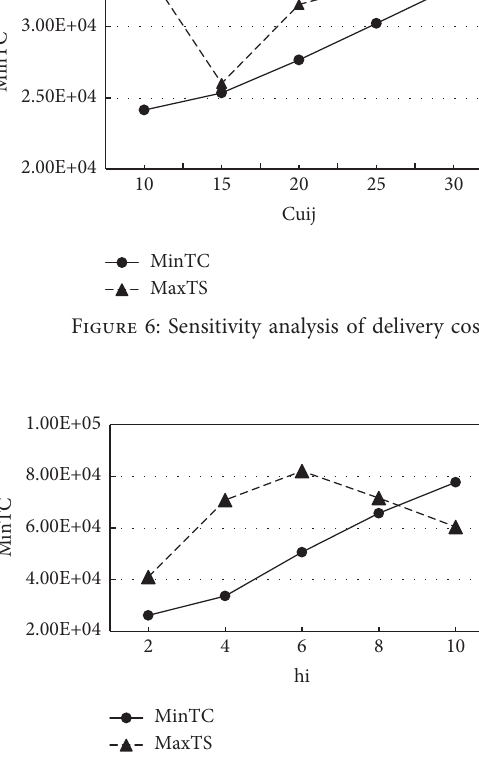
Figure 7: Sensitivity analysis of inventory cost.